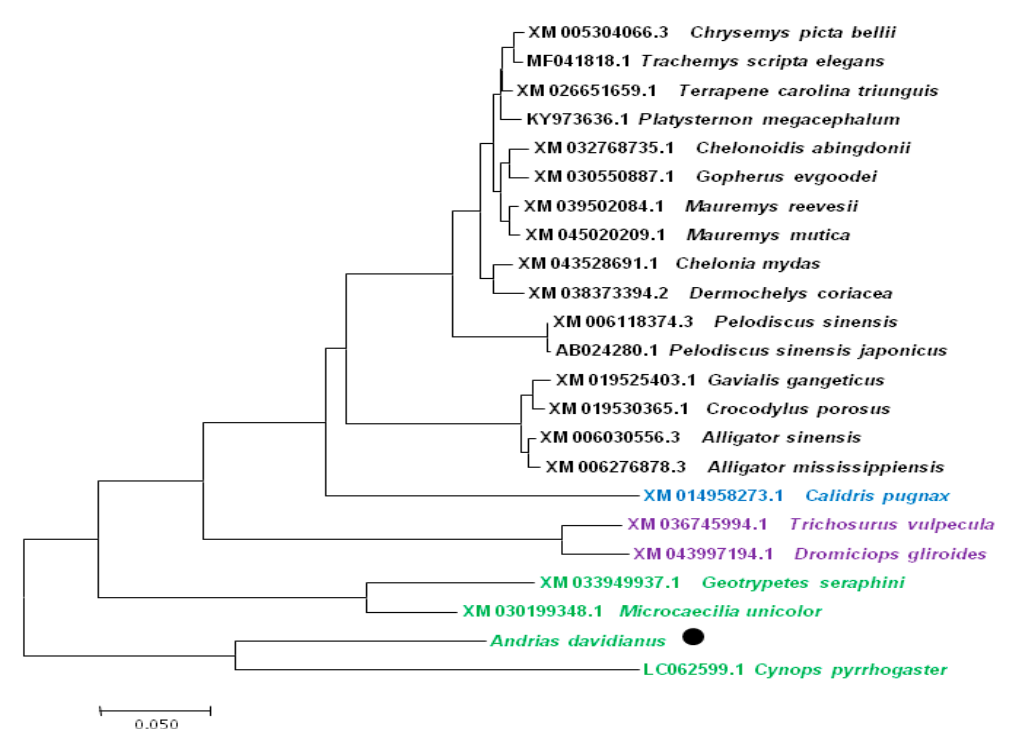
Figure 10. Phylogenetic tree of TYR from vertebrate. ● : indicates TYR from A. davidianus ; the black font represents Reptilia, the blue font represents Aves, the purple font represents Mammalia, the green font represents Amphibian; GenBank accession numbers of other vertebrates are listed.